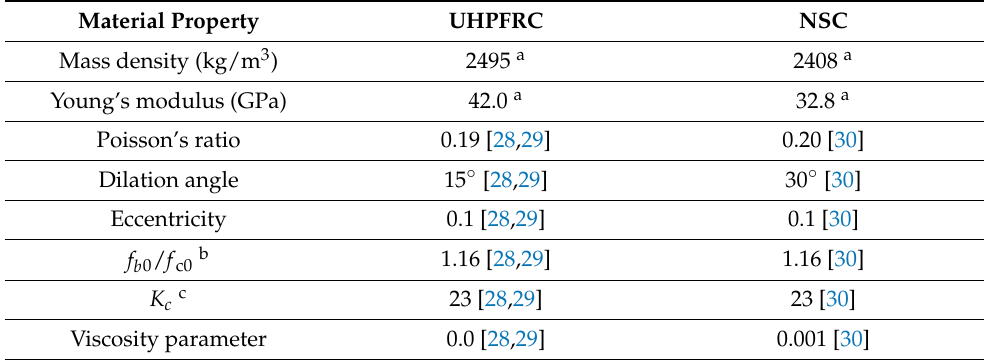
Table 5. Material properties of NSC and UHPFRC adopted in FE models.